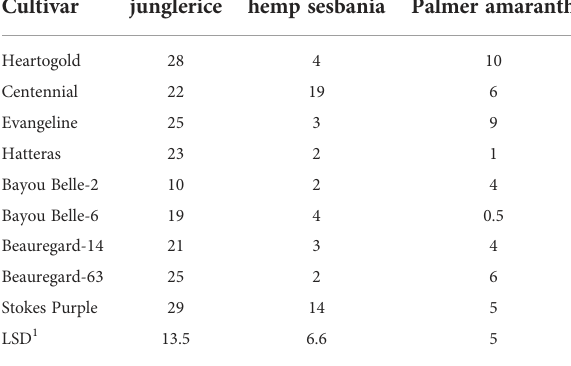
TABLE 4 Biomass reduction (%) of hemp sebania ( Sesbanea herbacea ), junglerice ( Echinochloa colona ), and Palmer amaranth ( Amaranthus palmeri ) seedlings when in contact with root leachates of nine sweetpotato cultivars at four weeks after emergence.